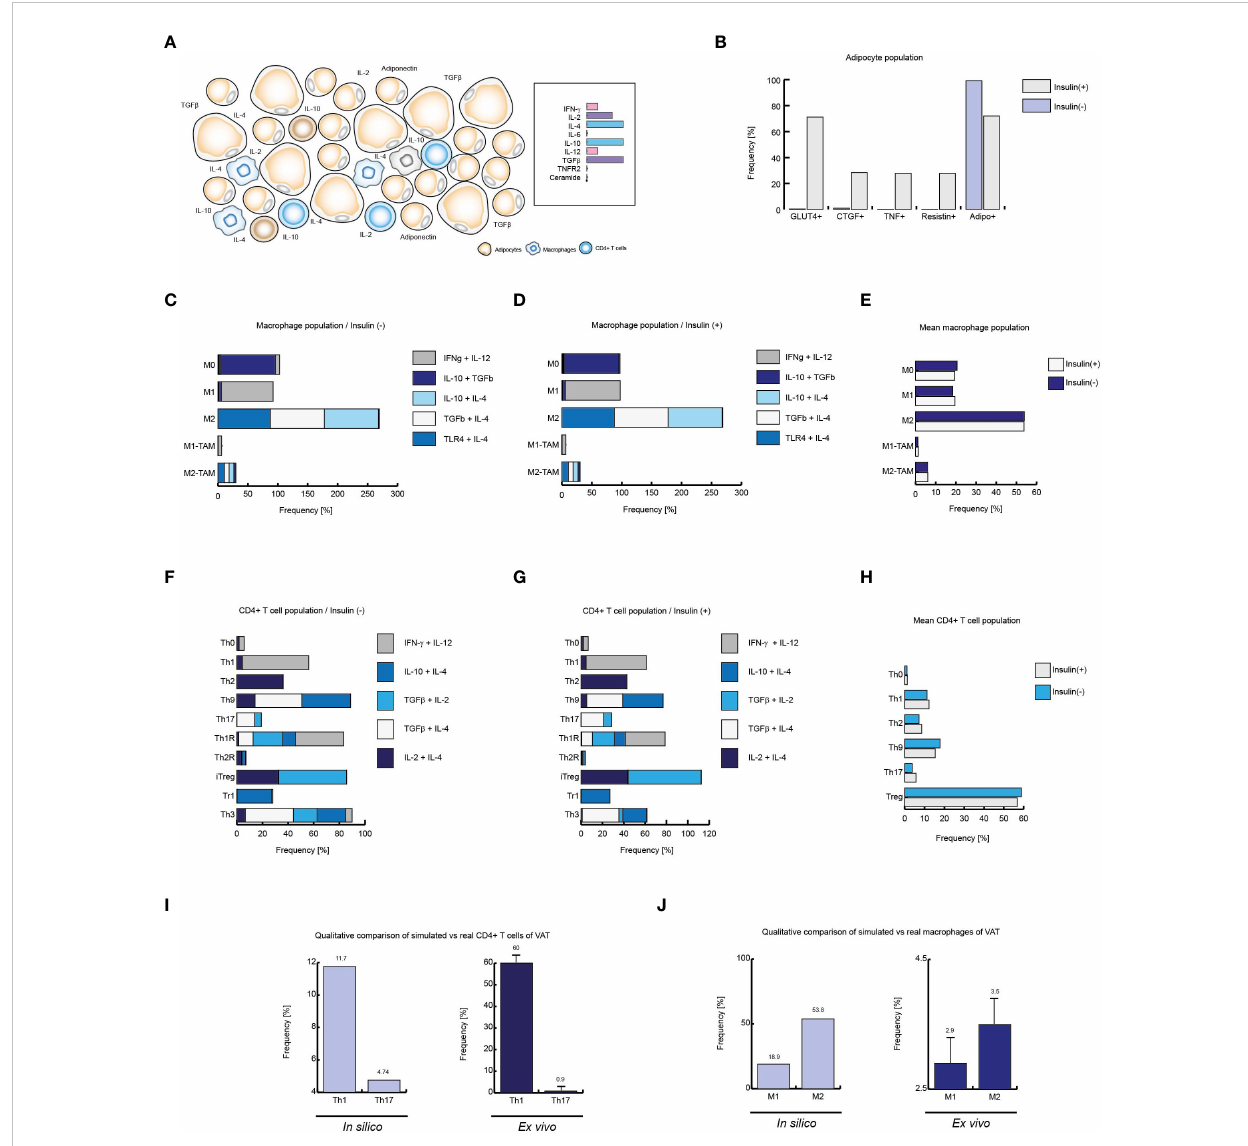
FIGURE 5 Insulin produces local in fl ammation on VAT cells. (A) Schematic representation of the simulated conditions within healthy lean subjects VAT, (B) Cell distribution of adipocytes with and without insulin. (C) Distribution of macrophage phenotypes without insulin, and D : with insulin. (E) Mean behavior of both phenotypic distributions. (F) Phenotype distribution of CD4+ T cells in absence of insulin, (G) and in presence of high levels of insulin. (H) Mean distribution of CD4+ T lymphocytes phenotypes. (I) Simulated Th1 and Th17 populations versus real frequencies of such phenotypes. (J) Simulated M1 and M2 populations versus their ex vivo frequencies. The values presented for panels (I, J) was adapted from (35) and (9) respectively. Collectively, these data suggest that insulin promotes in fl ammation in healthy VAT of lean